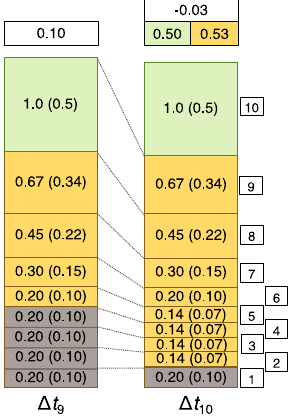
Figure 3. Scenario 3 showing a net loss of peat mass caused by the secondary decay of previously waterlogged layers of peat. During the drought in Δ t 10 the water table falls to the top of layer 1, exposing previously ‘protected’ peat in layers 2–5 to oxic decay (secondary